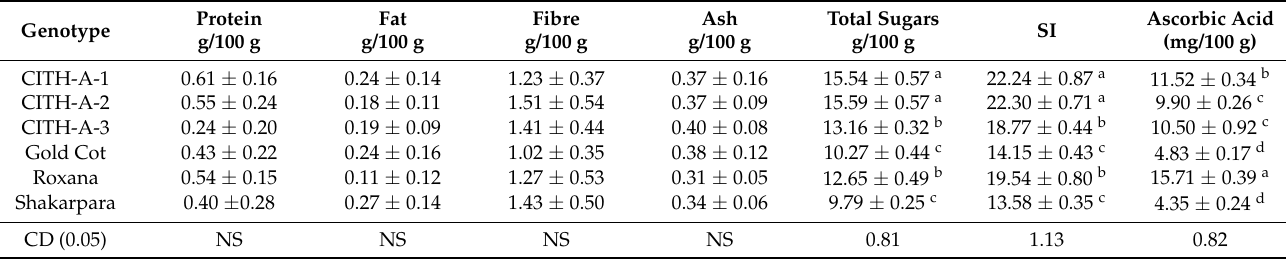
Table 3. Variation in the approximate composition and sweetness of apricot genotypes.